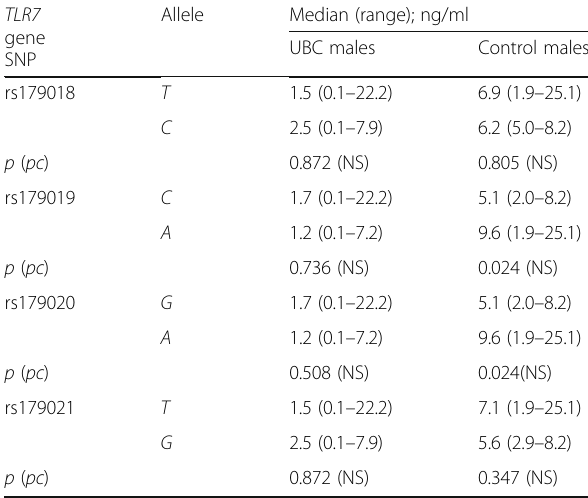
Table 5 Impact of TLR7 gene single-nucleotide polymorphisms on serum level of TLR-7 in males of urinary bladder cancer patients and control